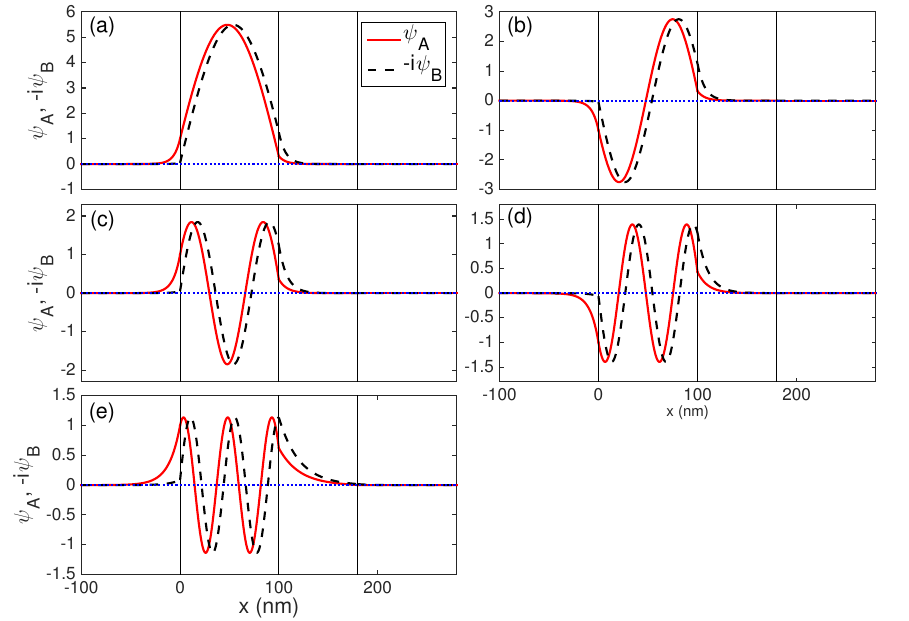
Figure 6. The wave function Ψ A (solid) and − i Ψ B (dashed) of guided modes as a function of distance corresponding to the intersections in Figure 3c: ( a ) k 2 x h 1 = 2.9025, θ = 79.9900 o